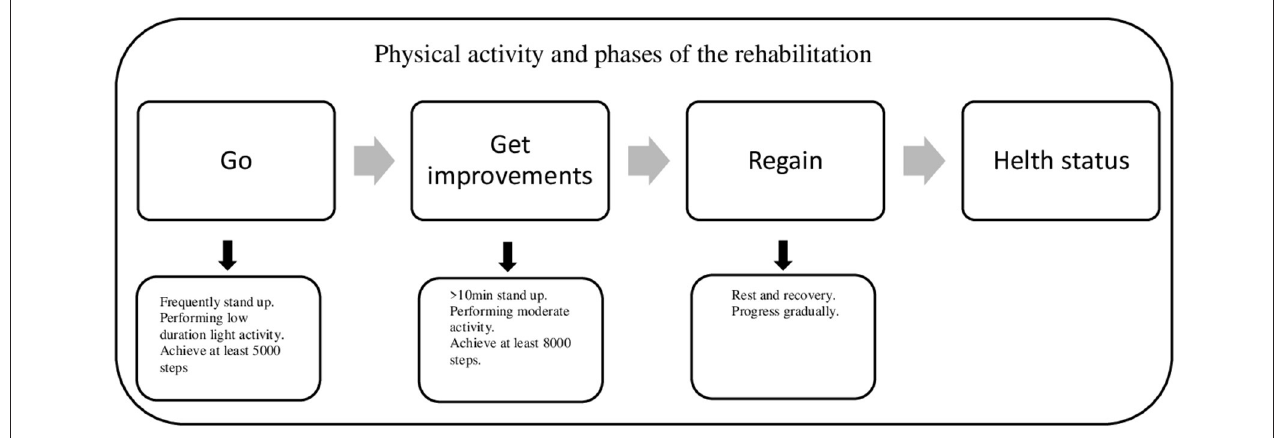
FIGURE 1 | Steps of rehabilitation during long COVID